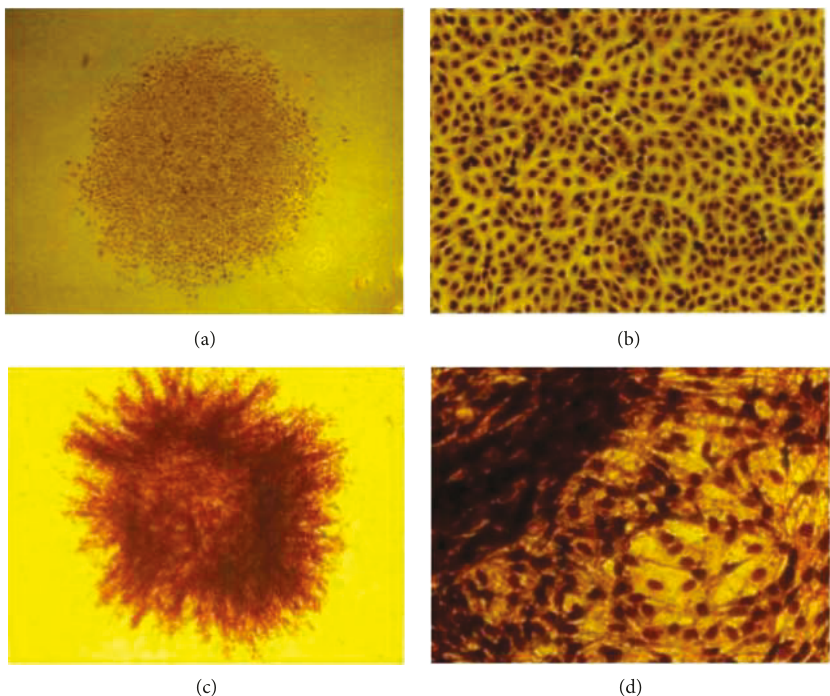
Figure 2: TheclonalfociformedbynormalBalb/c3T3cells(a,b)andtransformedfociaftermalignanttransformation(c,d)(Giemsastaining).